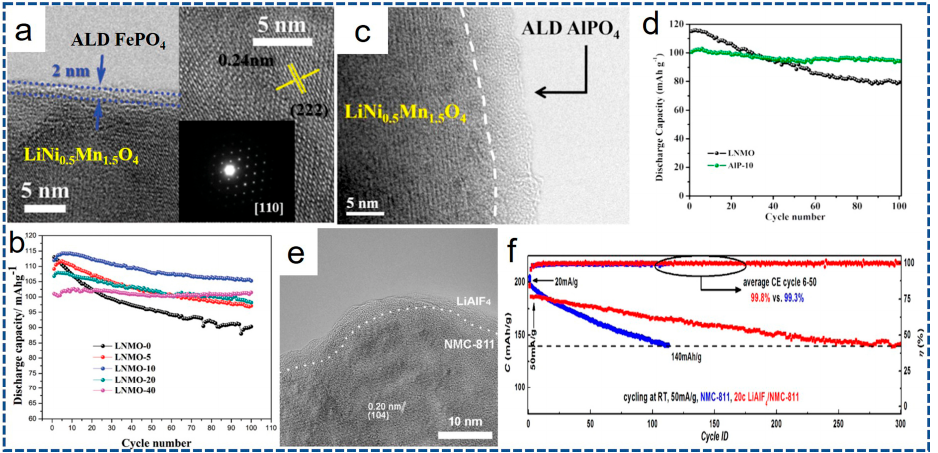
Figure 10. ( a ) HRTEM images and ( b ) cyclic stability of the ALD FePO 4 -coated LiNi 0.5 Mn 1.5 O 4 cathode. ( c ) HRTEM image and ( d ) cycling stability of the AlPO 4 -coated LiNi 0.5 Mn 1.5 O 4 cathode. ( e ) TEM image of the LiAlF 4 -coated NMC811 electrode after cycling. ( f ) Cycling behaviors of the pristine and LiAlF 4 -coated NMC811 electrodes at room temperature (RT) within an electrochemical window of 2.75–4.50 V (vs. Li/Li + ). ( a , b ) reprinted with permission from Ref. [158] @copyright 2015 Wiley. ( c , d ) reprinted